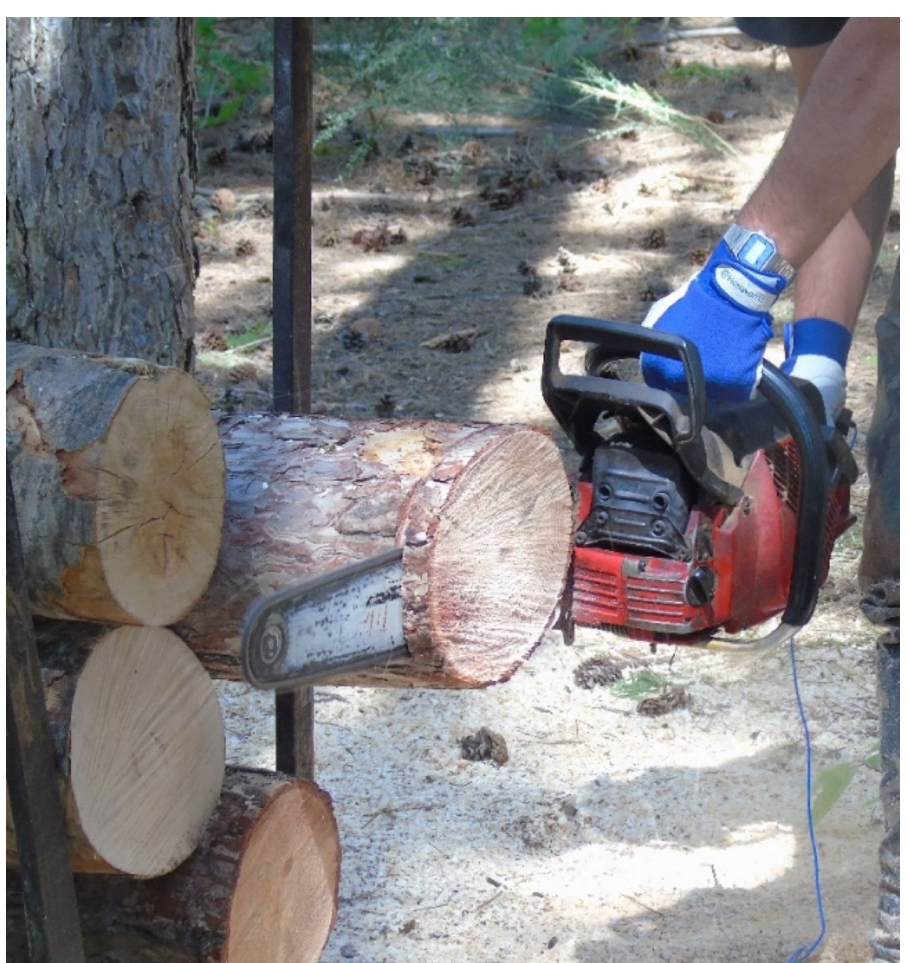
Figure 3. The noise and vibration measurements during cross-cutting